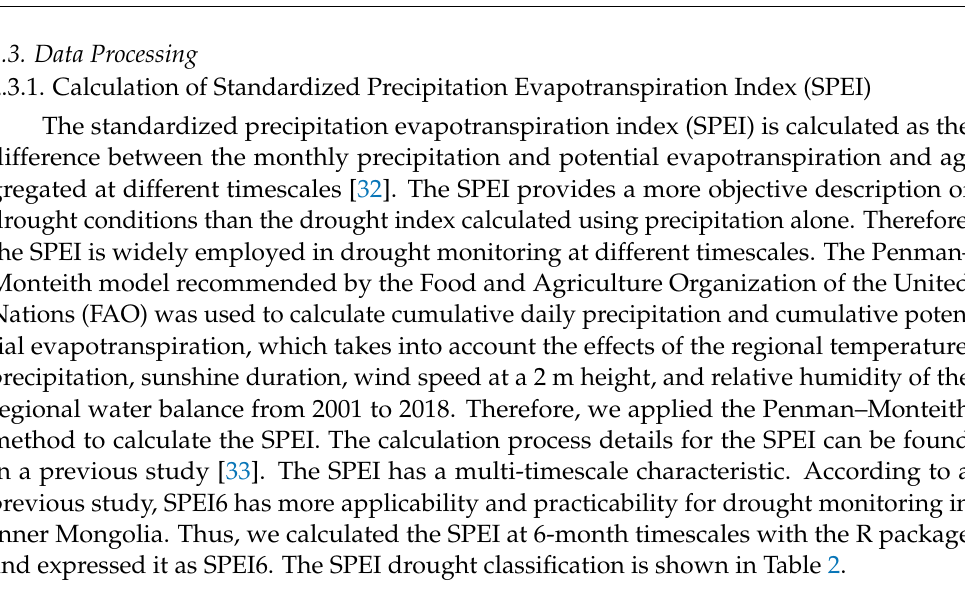
Table 2. Classification of SPEI